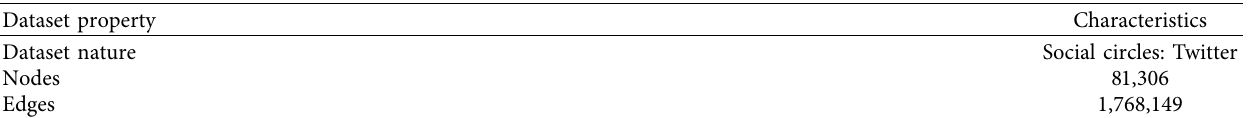
Figure 9: Hardware information of the target machine. Table 2: Dataset